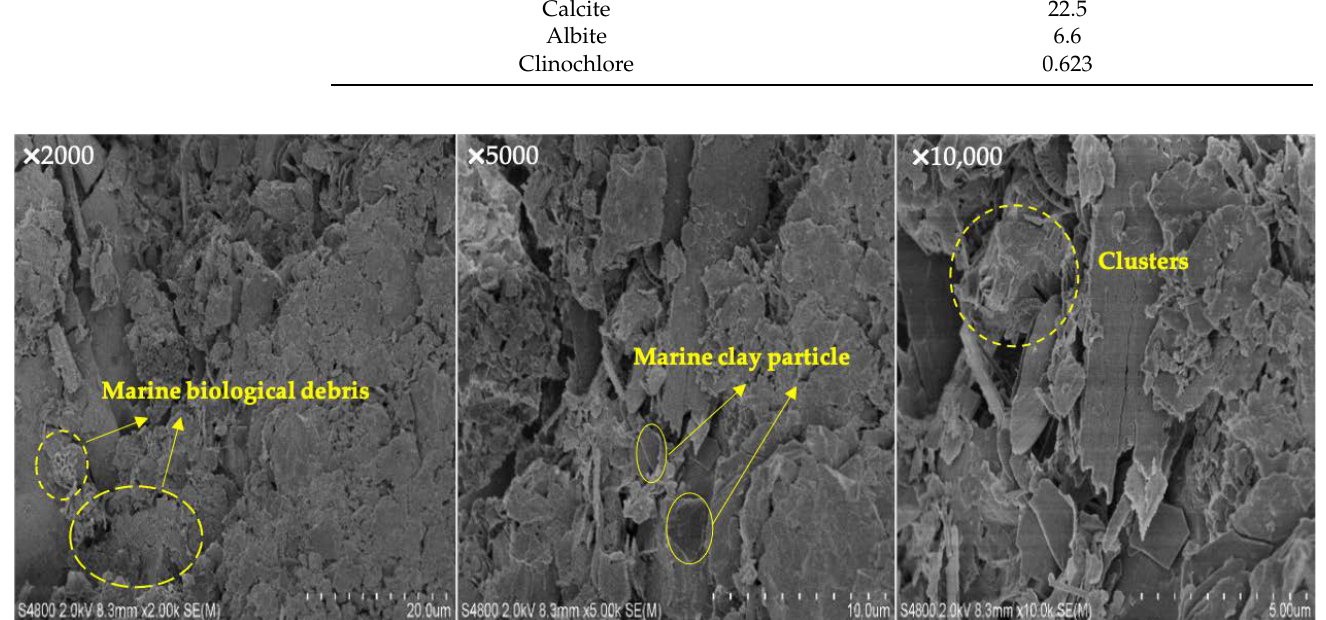
Figure 6. Microstructure of soil by SEM tests.